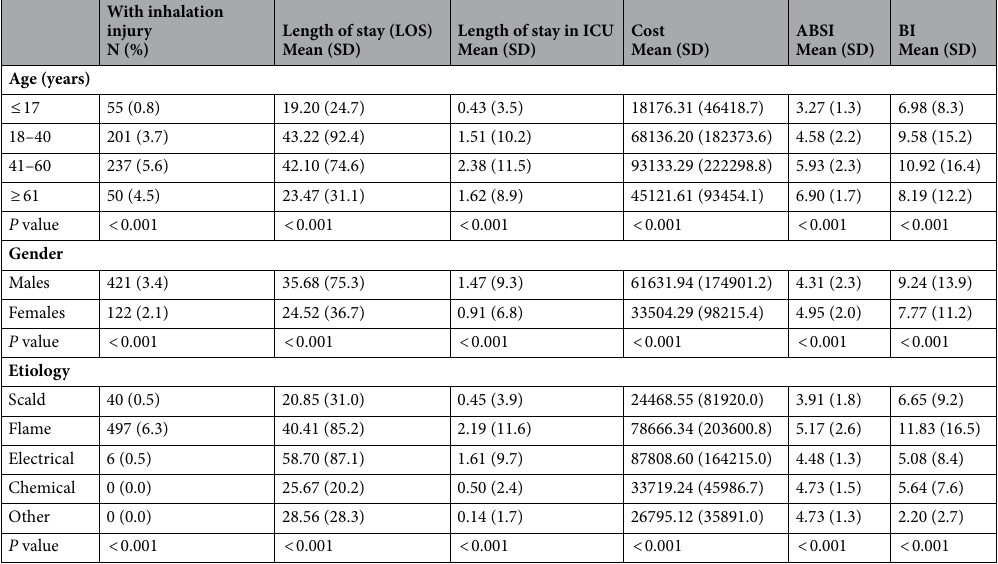
Table 4. Distribution of burn severity and burn outcomes by age, gender and etiology.